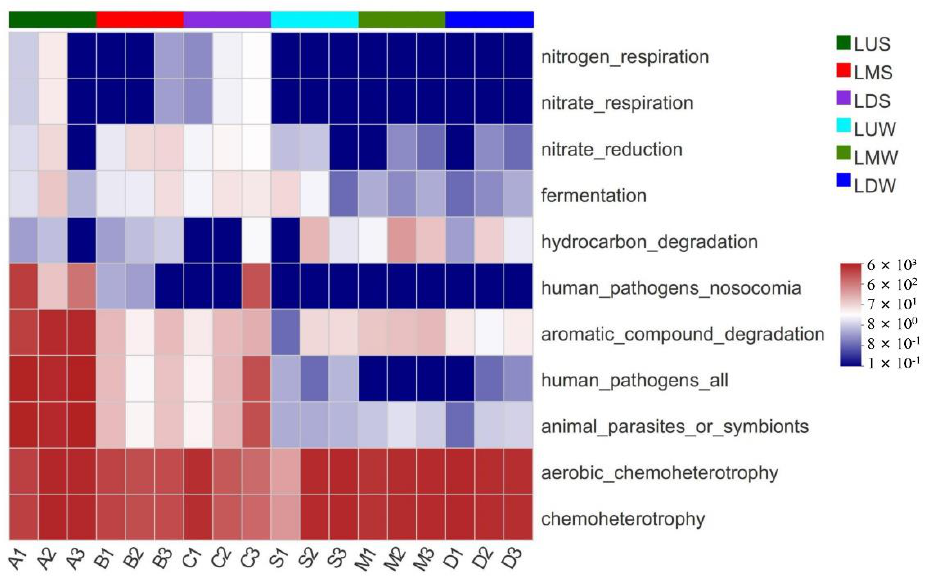
Figure 7. Relative abundance of predictive functions of epiphytic bacteria on submerged Spartina alterniflora in the coastal salt marsh area. Each group included three parallel samples.